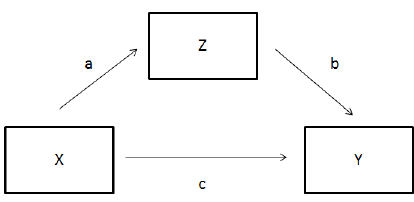
Figure 3. Standard mediation model showing both direct and indirect